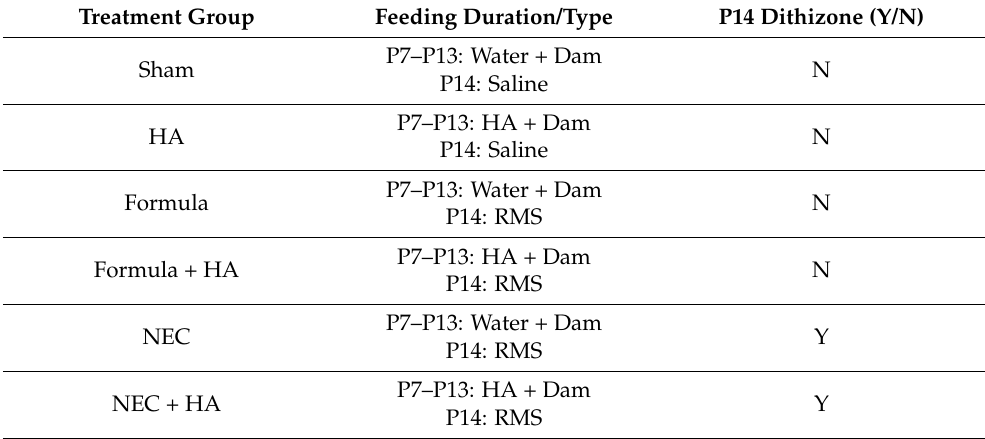
Table 2. Experimental Treatments and